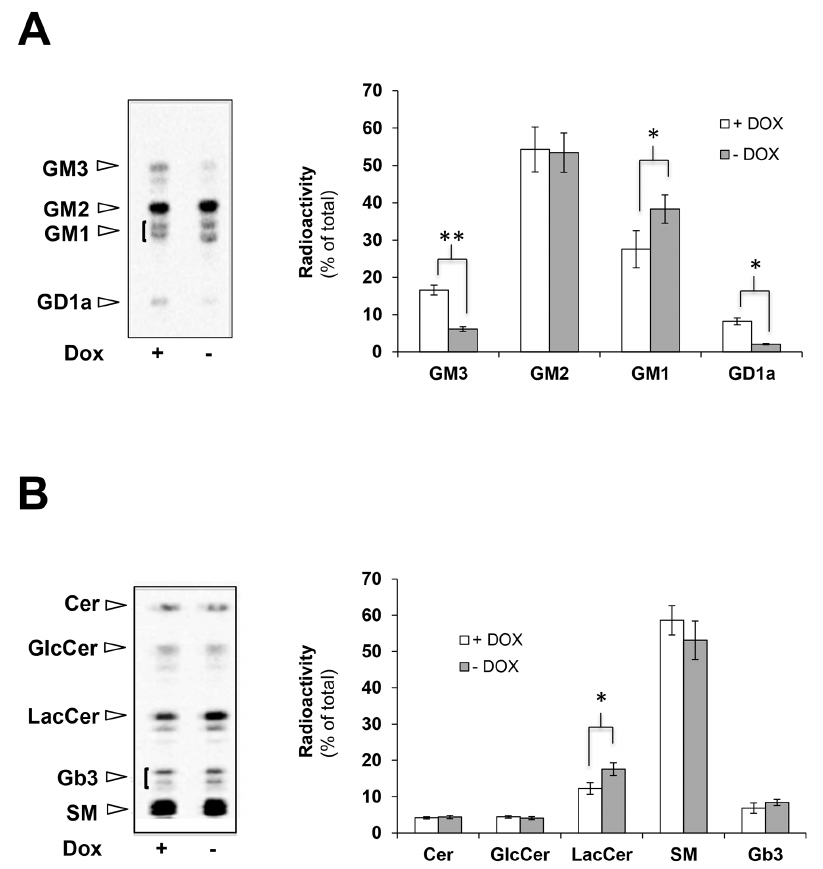
Figure 2. Expression of NEU3 results in the modification of the cellular ganglioside composition. OFF HeLa tTA2 NEU3-HA-GFP cells were plated and further grown for 72 h in absence (ON) or presence (OFF) of dox. Cells were then metabolically labeled for 2 h with [ 3 H]-sphigosine and chased for 48 h. Cell lipids were extracted and gangliosides (A) and non-ganglioside sphingolipids (B) were separated by HPTLC and visualized (left, Beta-Imager 2000) and associated radioactivity was determined (right, Beta-Vison). Values are given as percentage of total radioactivity and represent the means 6 S.D. of 5 independent experiments. *p , 0.05; **p , 0.01.